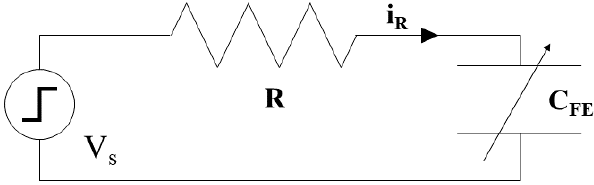
Figure 3. A ferroelectric capacitor in series with an external resistor. Vs is an independent voltage